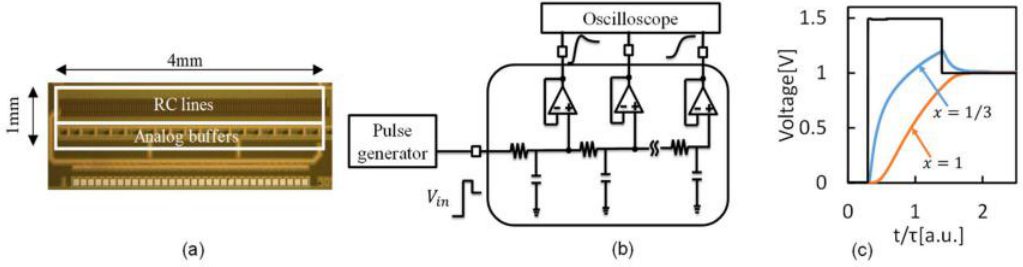
Figure 6. ( a ) die photo, ( b ) block diagram of the test circuit, and ( c ) voltage waveform at x = 1 and 1/3 ( α = 1.5). T DLY is measured with T PRE varied at x = 1/6, 1/3, 1/2, and 1 to determine optimum T PRE for minimizing T DLY at each x. Except for x = 1/6, T PRE has the window whose edge